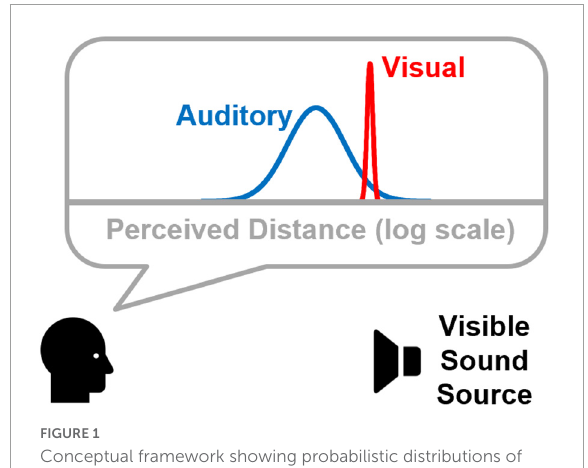
FIGURE1 Conceptual framework showing probabilistic distributions of perceived auditory and visual target distances. Note that both are represented on a logarithmic distance axis, and that perceived auditory distance both underestimates the physical distance to the sound source and is less precise. These aspects of the framework were motivated by results previous data sets (Zahorik, 2002; Anderson and Zahorik, 2014).